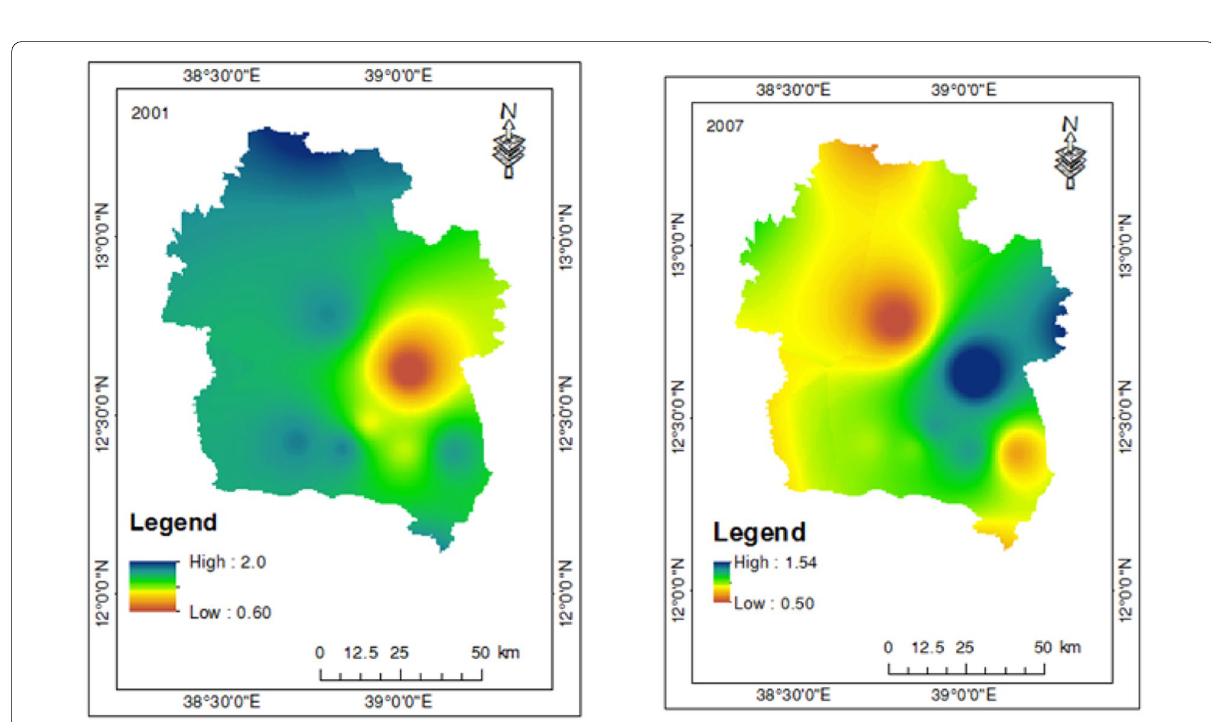
Fig. 13 Standard Precipitation Index for wet year 2001 and